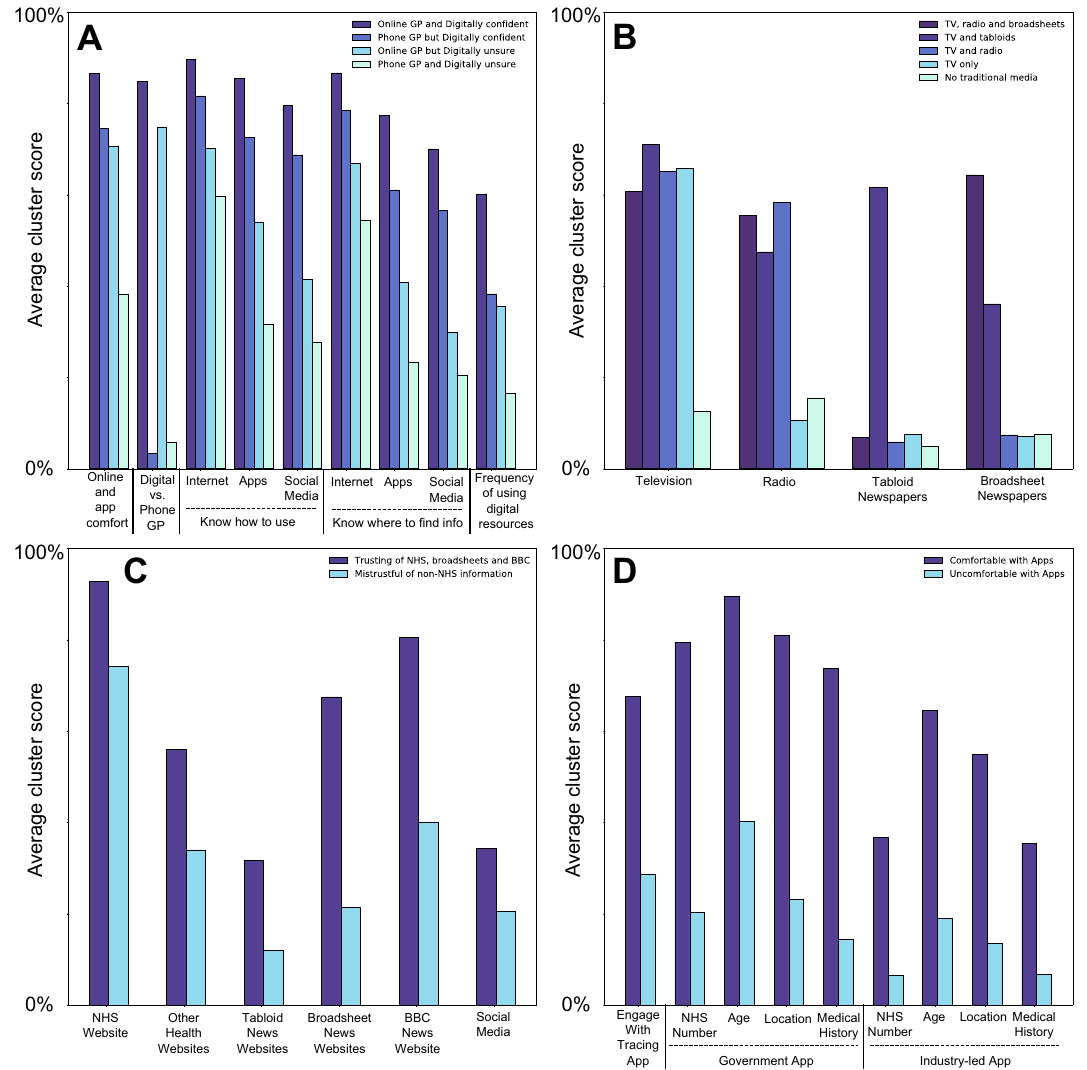
Figure 2. 4 bar graphs (labelled Panel A, B, C and D) detailing discrete response types within survey domains, achieved through K-means cluster